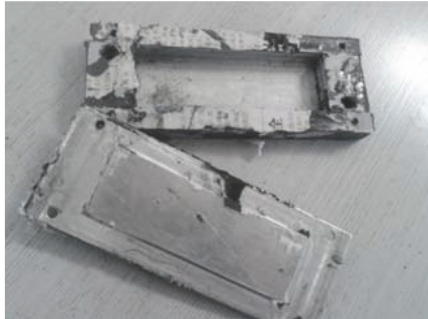
Figure 15: Aluminum alloy